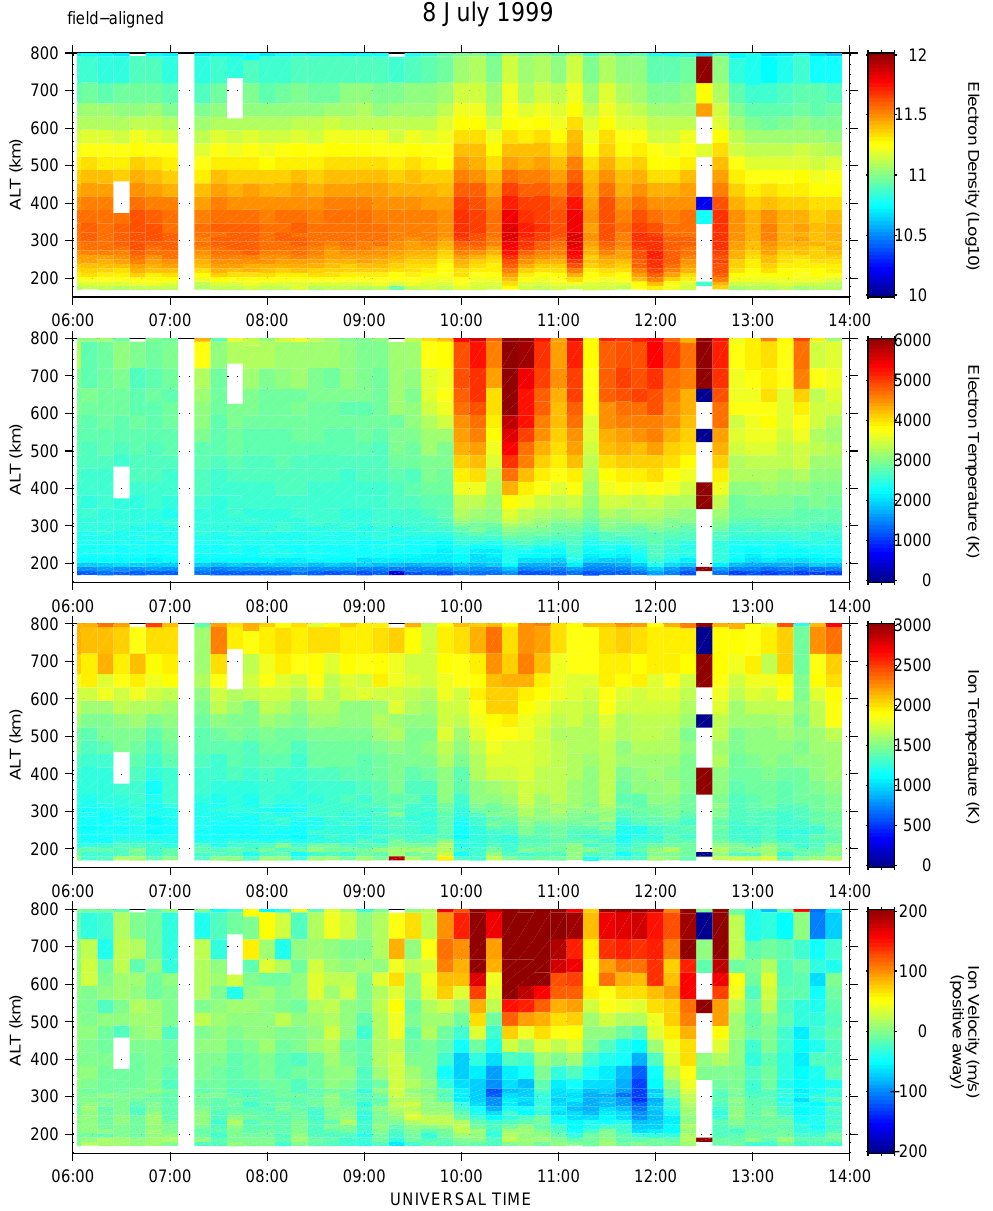
Fig. 1. Overview plot of ESR data from 08 July 1999, 06:00–14:00UT. Panels from top to bottom show electron density, electron temperature, ion temperature, and ion velocity color-coded over altitude (y-axis) and time (x-axis). The velocity is red for flow away from the radar (upward) and blue for flow toward the radar (downward). Plotted are only data from the field-aligned position of the ESR antenna doing a scan cycle over 4 positions (Common Progamme 2). The data from the field-aligned position are extrapolated to times when the antenna is not